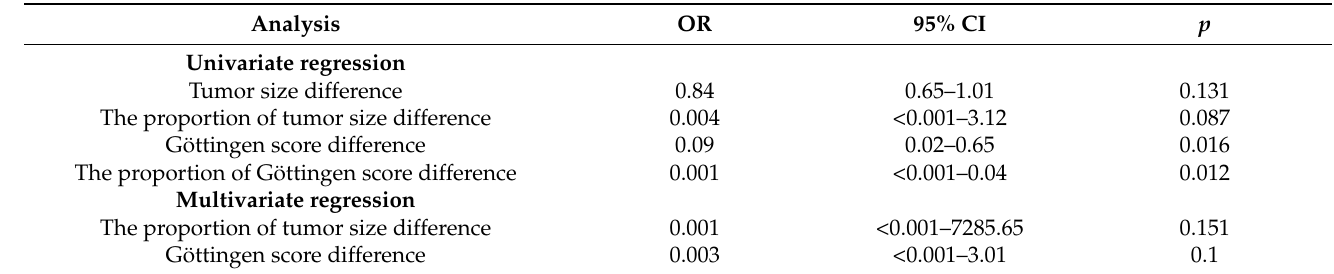
Table 5. Univariate and multivariate analyses of the impact of differences in tumor characteristics before and after second cycle of